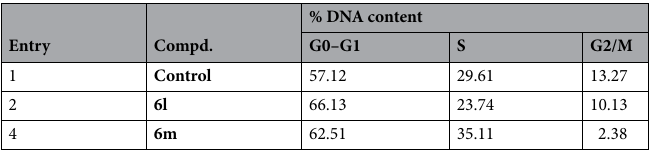
Table 2. % DNA cell distribution of compounds 6l , 6m and control experiment for MCF7 (breast cancer cell line) by PI-FC.